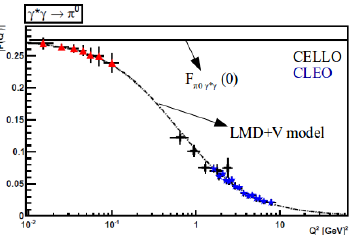
Figure 5: Simulation of KLOE-2 measurement of F ( Q 2 ) (red triangles) with statistical errors for 5 fb − 1 ref.